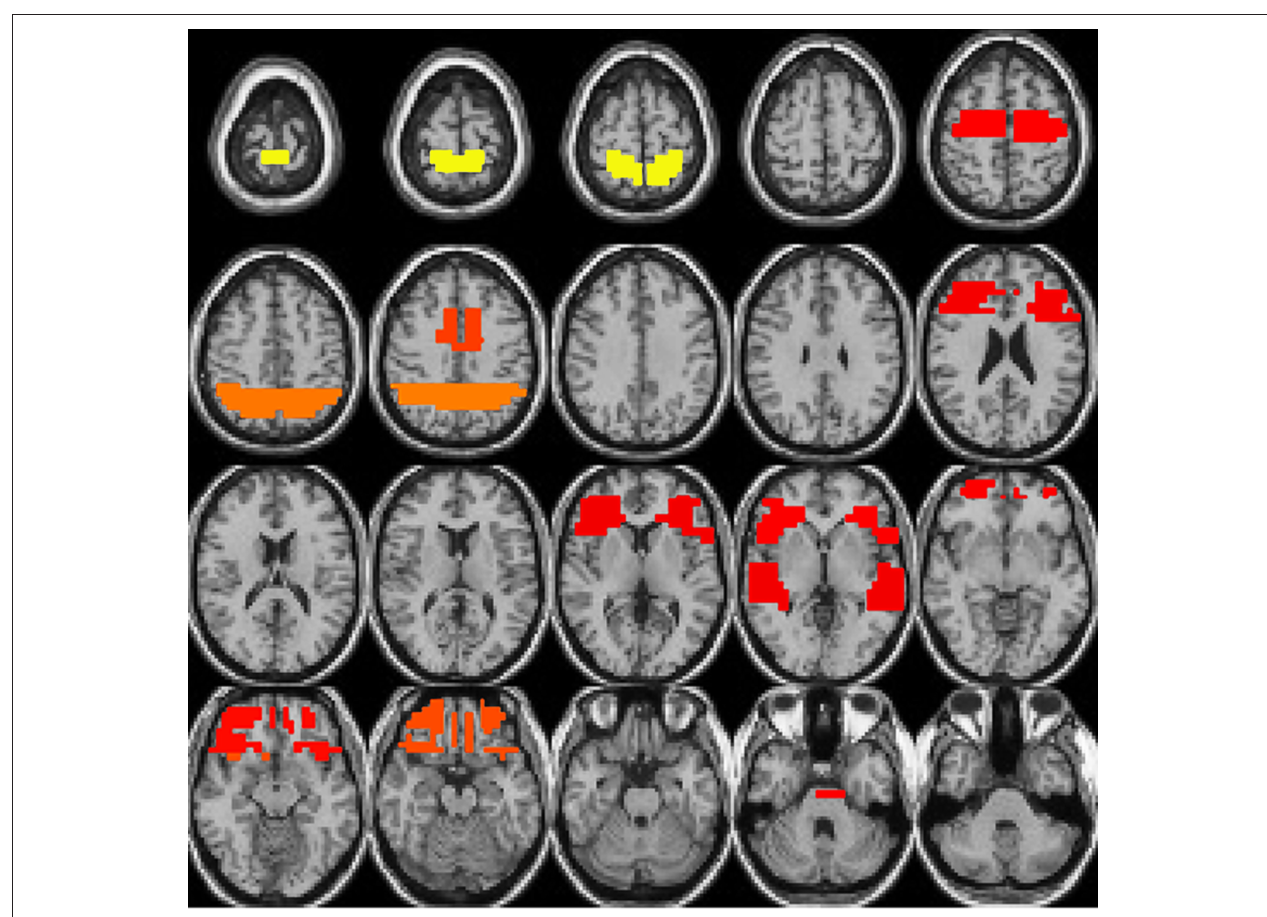
Figure 3 | The location of selected voxels.